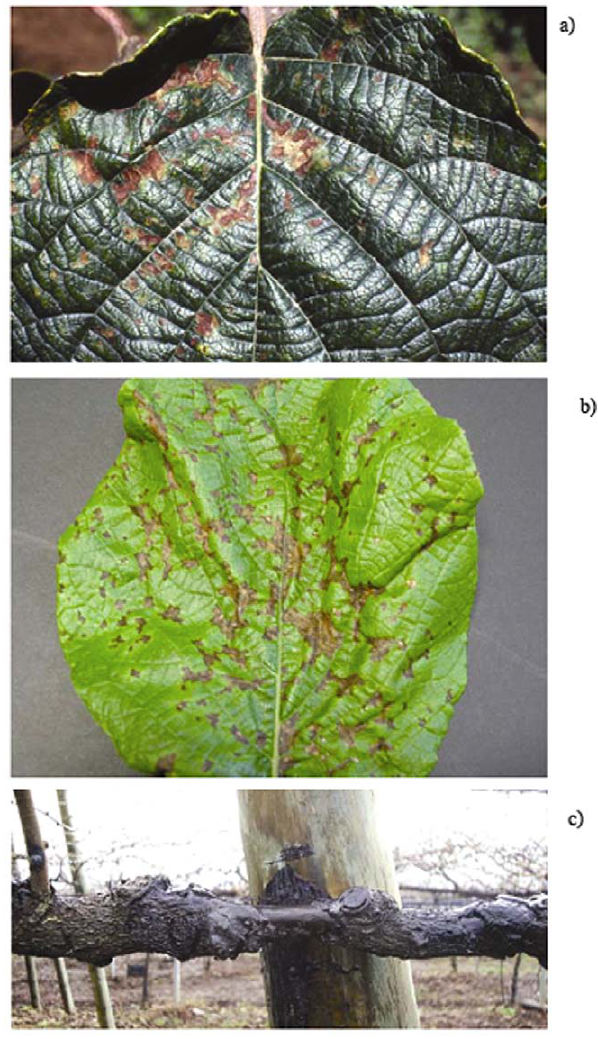
Figure 1. Disease symptoms of Psa on Actinidia spp. leaves and main leader. The sequenced I- Psa and I2- Psa strains from Italy were isolated from the leaves herein showed. A) Leaf symptoms on Actinidia deliciosa cv. Hayward (June, 1992); b) leaf symptom on A. chinensis cv. Hort16A (June, 2008). Note the red-rusty colour of the spots and the chlorotic halo on A. deliciosa and the brownish spot without halo on A. chinensis ; c) large canker in deep winter, induced by Psa on the main leader of an adult A. chinensis cv. Hort16A plant, in central Italy (February, 2009). Note the complete destruction of all the external woody tissues of the